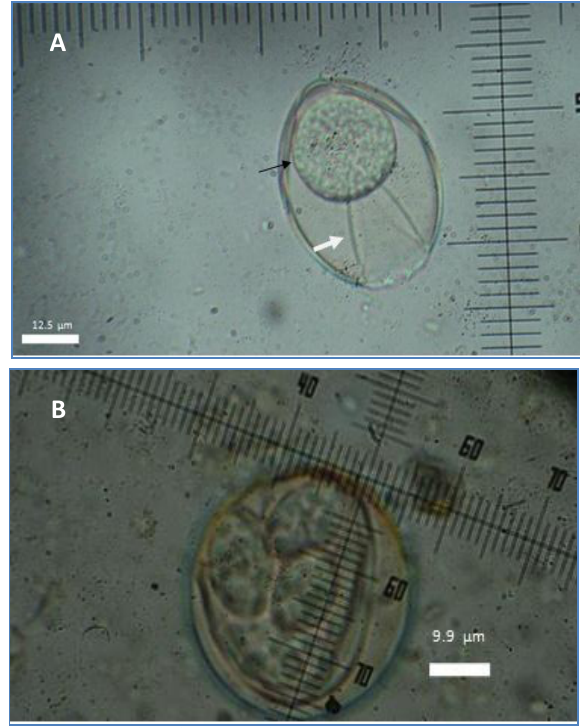
Figure, 3: Eimeria caprovina oval Oocyst with micropyle (white arrow) and no cup (A) with clear germinal disk (black arrow) with outer and inner layer as well as four elongated fat sporocysts (B) were observed by saturated salt solution